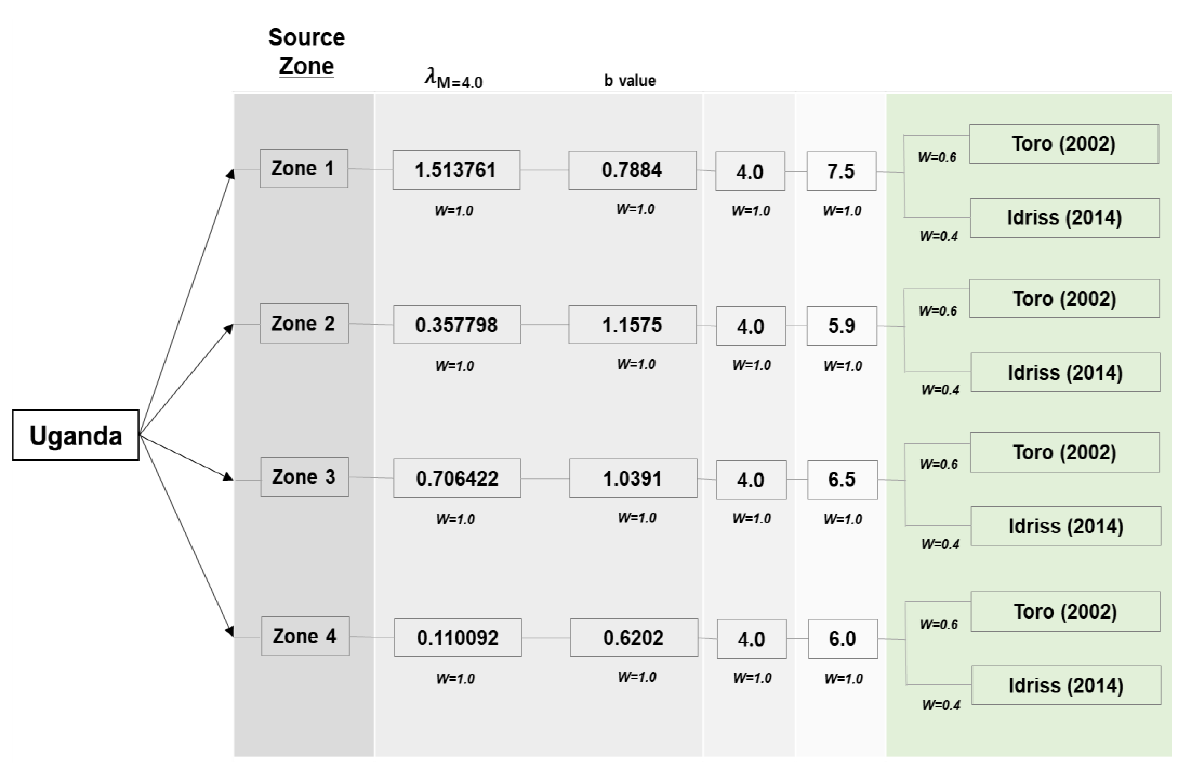
Figure 2. Logic tree used in this study.